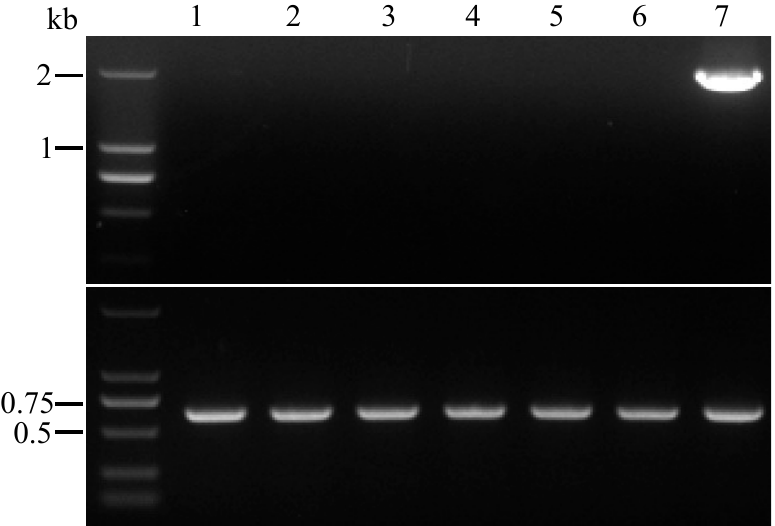
Figure 7. Verification of AnamdS gene looping out. Upper: PCR was carried out using the primers targeting the AnamdS marker. Lower: DNA template quality of the tested samples was validated using primers flanking the ITS region The F190- ∆ spm11 - AnamdS strain carrying AnamdS marker was set as positive control. (Lane 1–6: ∆ spm11 mutants without AnamdS marker; Lane 7: positive control).